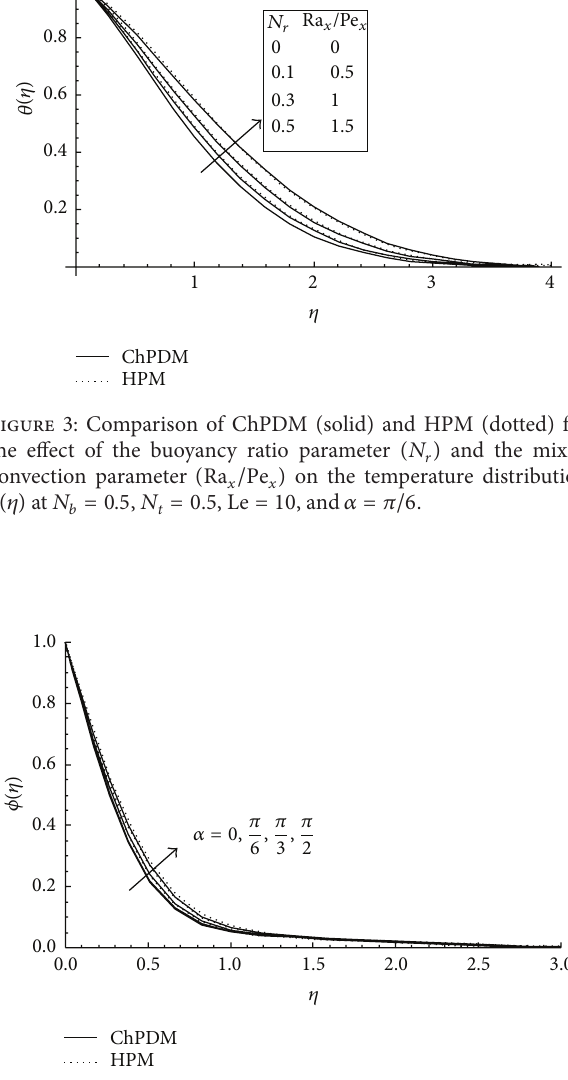
Figure 4: Comparison of ChPDM (solid) and HPM (dotted) for the effect of the angle of inclination (𝛼) on the nanoparticle concentration distribution 𝜙(𝜂) at 𝑁 𝑏 = 0.5 , 𝑁 𝑡 = 0.5 , 𝑁 𝑟 = 0.5 , Le = 10 , and Ra 𝑥 / Pe 𝑥 = 0.5 .